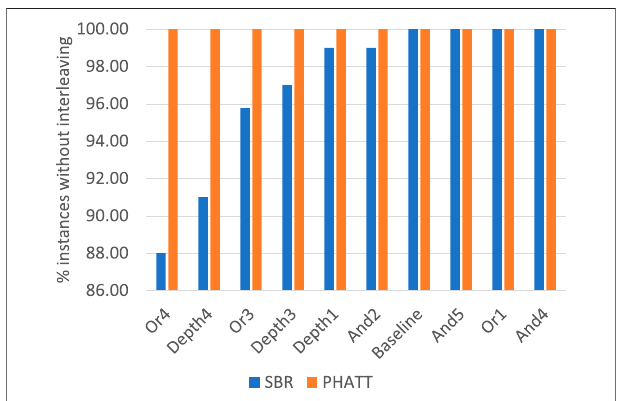
FIGURE 13 | Percentage of instances that each algorithm captures if interleaving is allowed.